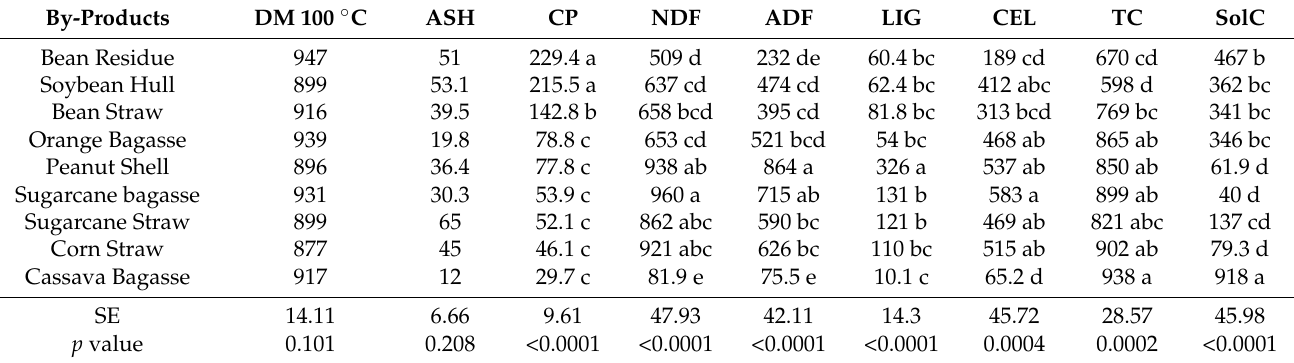
Table 1. Chemical composition (g kg − 1 DM) of the by-product samples